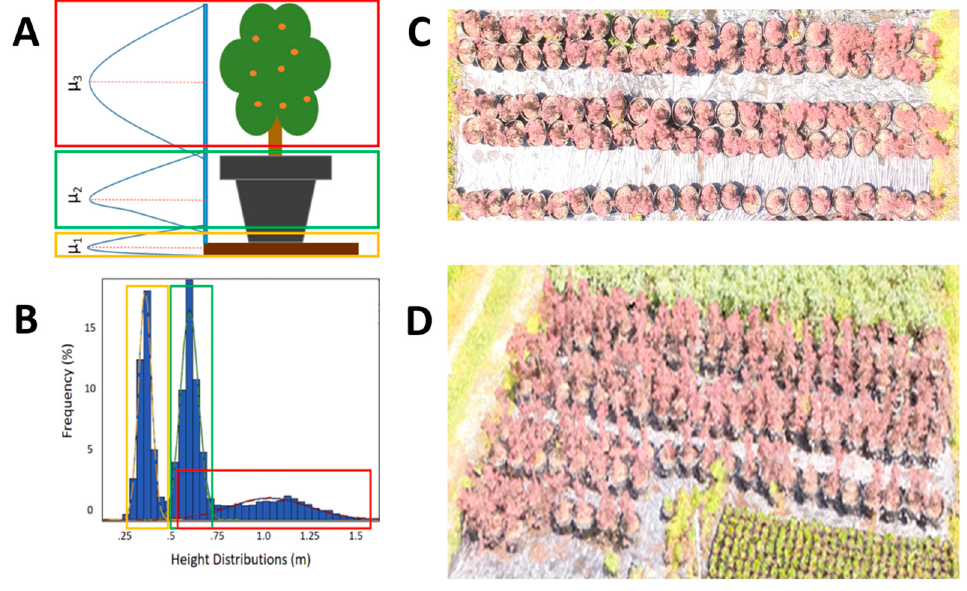
Figure 4. ( A ) Features in the field are represented accurately by a finite mixture model (FMM). ( B ) Data from Amerson’s Nursery: the first distribution (yellow box) corresponds to the “ground” class of data points in the point cloud, the second distribution (green box) corresponds to the “pots” class of data, and the third distribution (red box) corresponds to the “plants” class of data. Overlap in these distributions results from plant-to-plant, pot-to-pot, and across-ground variation in height. ( C ) Single aerial image of the area corresponding to data shown in panes ( A ) and ( B ). ( D ) An oblique-angle render of the 3D point cloud from Amerson’s Nursery in SC, showing the potted plants’ and pots’ heights.